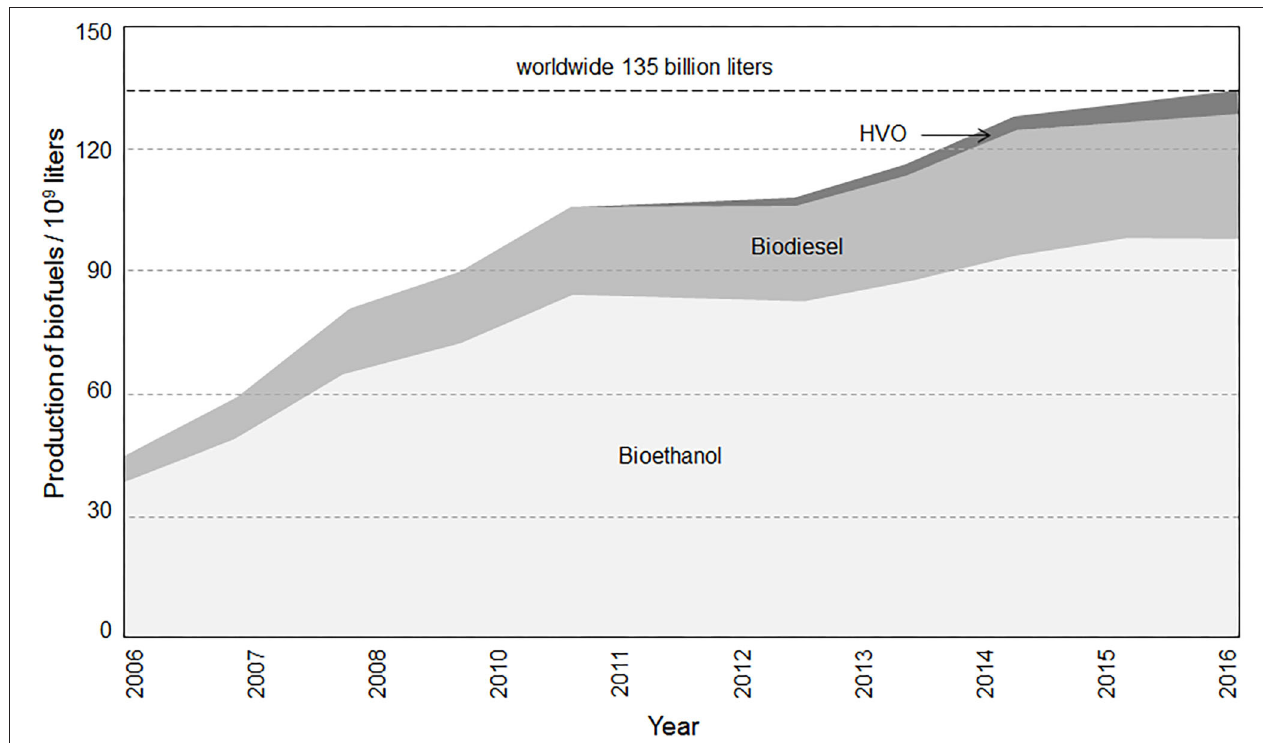
FIGURE 1 | Global trends in bioethanol fuel (light gray), biodiesel (gray), and hydrotreated vegetable oil (dark gray) production from 2006–2016 (author’s illustration based on Moeltner, 2018; REN21,